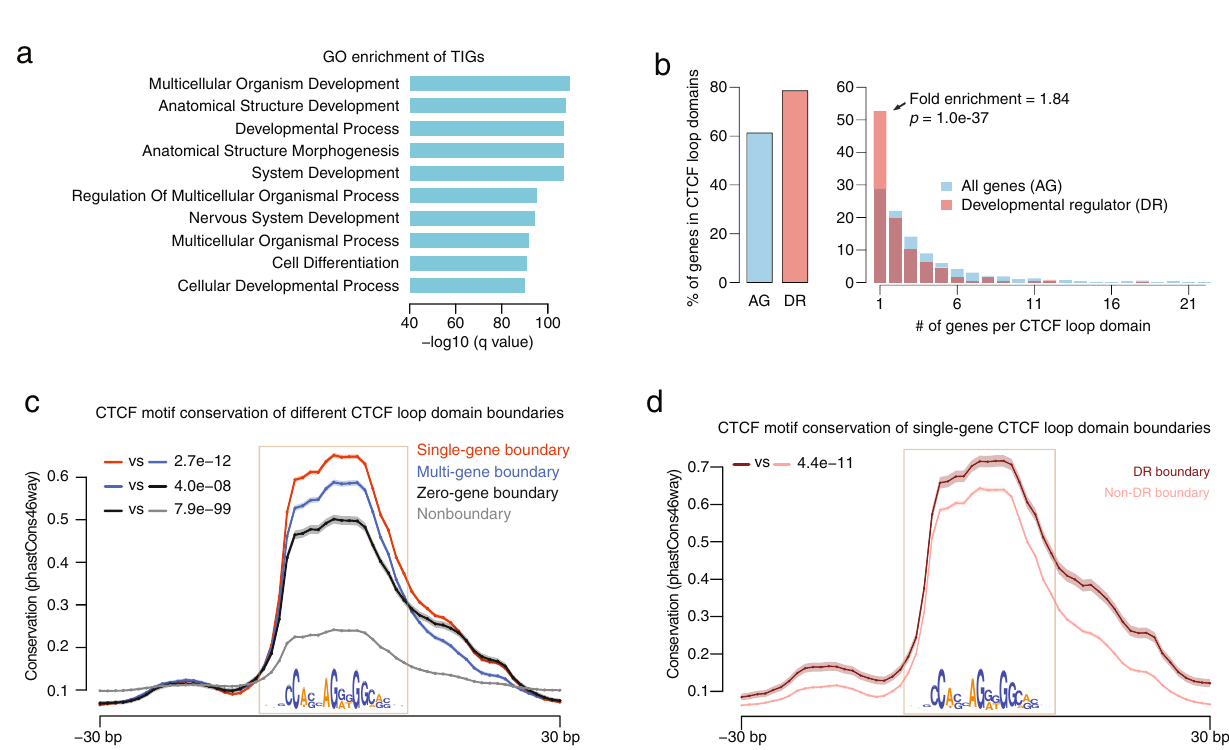
Fig. 2 CTCF loop domain boundaries in ES cell differentiation. a Boundary-anchored virtual 4 C heatmap of the domain boundaries in HUES64 and its derivatives. The locations of domain boundaries were identi fi ed in HUES64 Hi-C data. The − log10 P -value (before adjusting for multiple comparisons) obtained from Fit-Hi-C software are shown. Each row represents the domain of one gene. The strongest domain (i.e., that with the lowest Hi-C interaction P -value between boundaries) per gene is shown if there are multiple domains for that gene. b Boundary-anchored virtual 4 C heatmap of the domain boundaries identi fi ed from HUES64 Hi-C data plotted by using the Hi-C data of HUES64 and its derivatives as the underlying contact maps. The normalized Hi-C interactions are shown. The ordering is the same as in a . c Boundary-anchored virtual 4 C average pro fi le of the domain boundaries in HUES64 and its derivatives. The locations of domain boundaries were identi fi ed in HUES64 Hi-C data. The normalized Hi-C interactions are shown. The dotted line separates the left and right boundary regions, which represent the regions in the left and right heatmap in b . Average signals across all boundaries are shown with the shaded area indicating the standard error. Two-sided Wilcoxon test was used to determine signi fi cance level of boundary-to-boundary interactions between the two groups. Data are presented as mean values ± SE. d Hi-C signal fold-change of boundary-to-boundary interactions in HUES64 derivatives over HUES64 cells. Two-sided Wilcoxon test p -value is shown. Hi-C signals were normalized by library size in individual samples prior to the analysis. The box indicates the interquartile range (IQR), the line inside the box shows the median, and whiskers show the locations of either 1.5 × IQR above the third quartile or 1.5 × IQR below the fi rst quartile, n = 3,310 boundary-to-boundary interactions for single-gene domain, n = 8,729 boundary-to- boundary interactions for multi-gene domain. e Boundary-anchored virtual 4 C average pro fi le of the domain boundaries at the 2-cell, 8-cell, 8-cell treated with α -amanitin, morula, blastocyst stages, and 6-week embryos. The locations of domain boundaries were identi fi ed in HUES64 Hi-C data. CTCF expression is inhibited under α -amanitin treatment at the 8-cell stage. The normalized Hi-C interactions are shown. The dotted line separates the left and right boundary regions. Average signals across all boundaries are shown with the shaded area indicating the standard error. Two-sided Wilcoxon test was used to determine the signi fi cance level of boundary-to-boundary interactions between the two groups. Data are presented as mean values± SE.